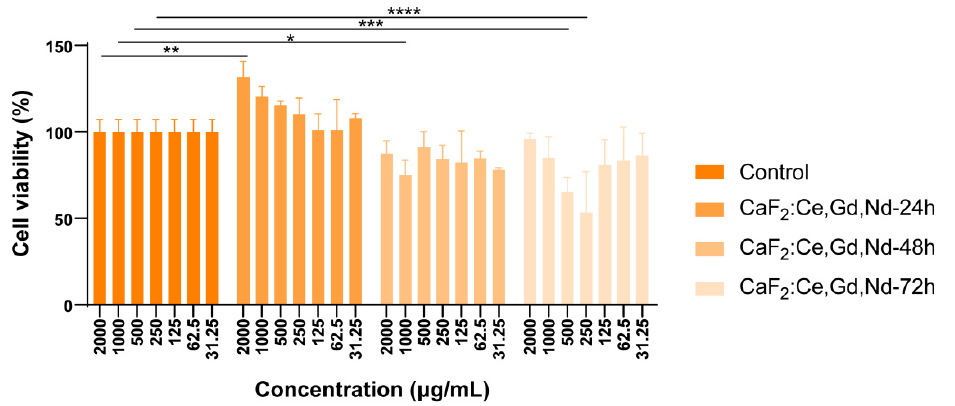
Figure 4. Cell viability. 4T1 cells were treated with CaF 2 : Ce, Gd, Nd NPs at varying concentrations